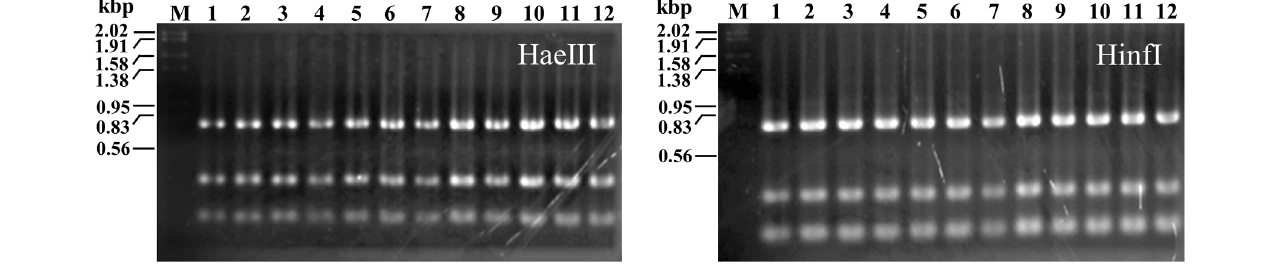
Figure 4. PCR-RFLP profiles of 16S rDNA of TAT105, Bacillus thermolactis , Bacillus kokeshiiformis , and TAT bacteria in the composts digested with HaeIII and HinfI. Lanes: M, marker (Marker 2, Nippon Gene Co Ltd., Tokyo); 1, TAT105; 2, B. thermolactis strain R-6488 T ; 3, B. kokeshiiformis strain MO-04; 4–12, TAT bacteria isolated from swine manure (4–6), cattle manure (7–9), and excess sludge (10–12)